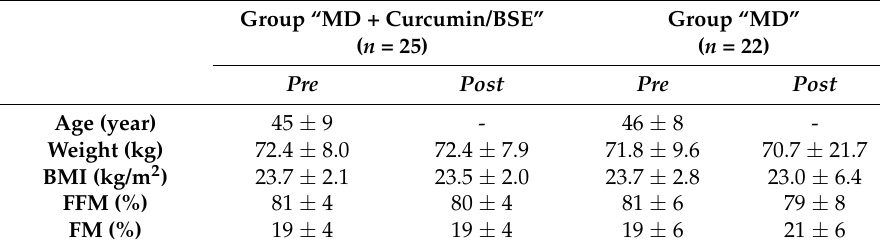
Table 1. Basal characteristics of the patients